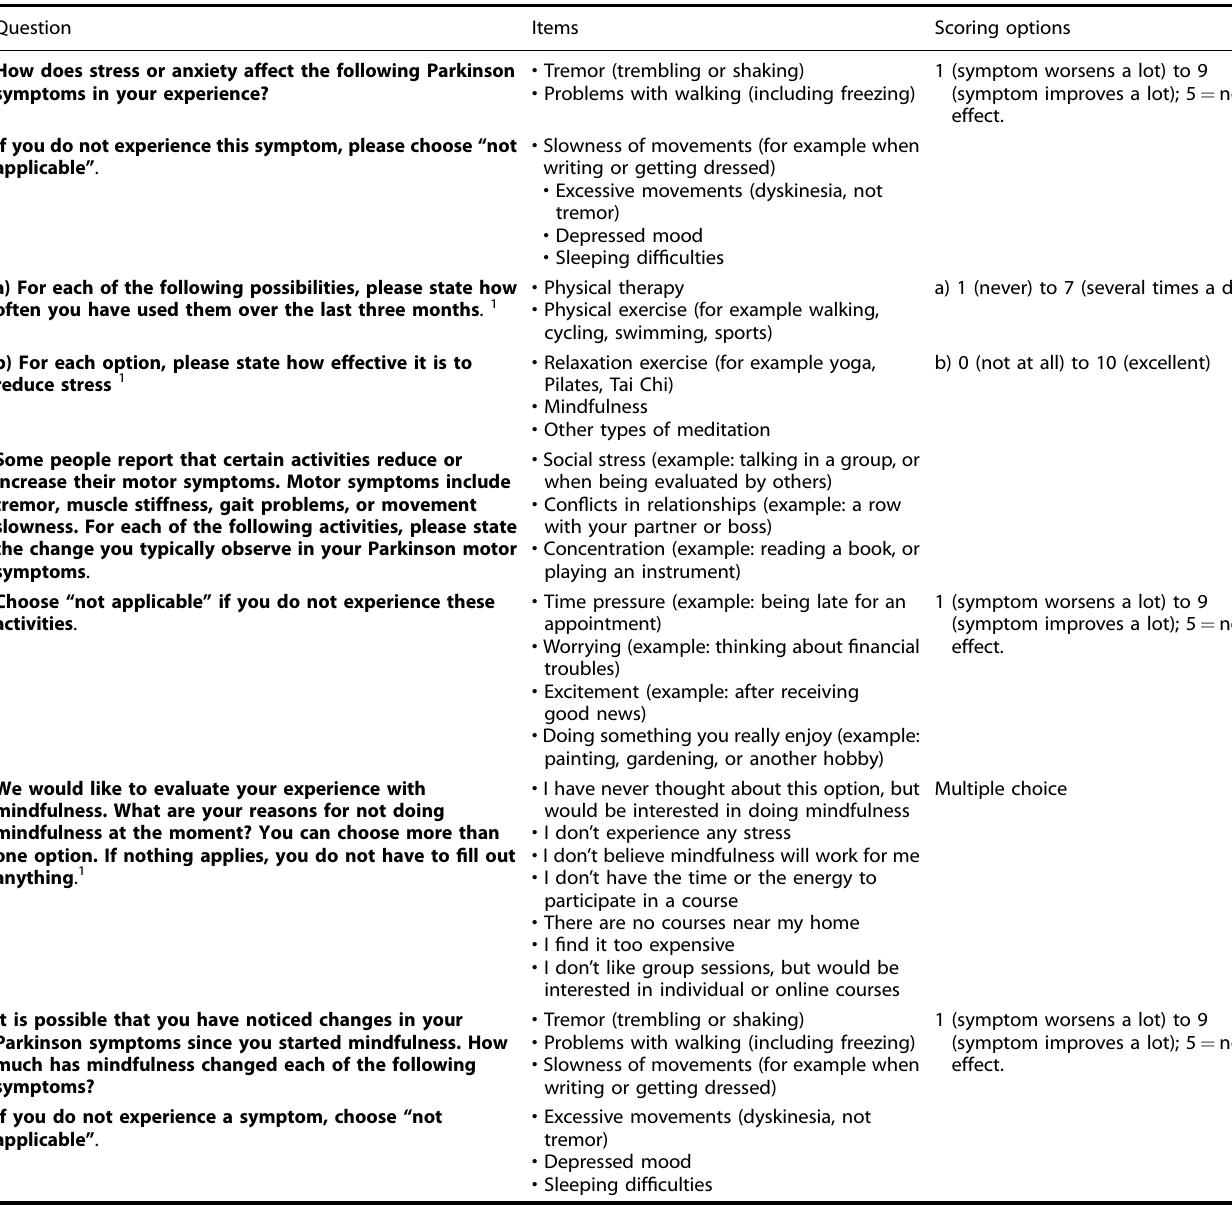
Table 2. Additional questions in the one-time stress survey. Question Items Scoring